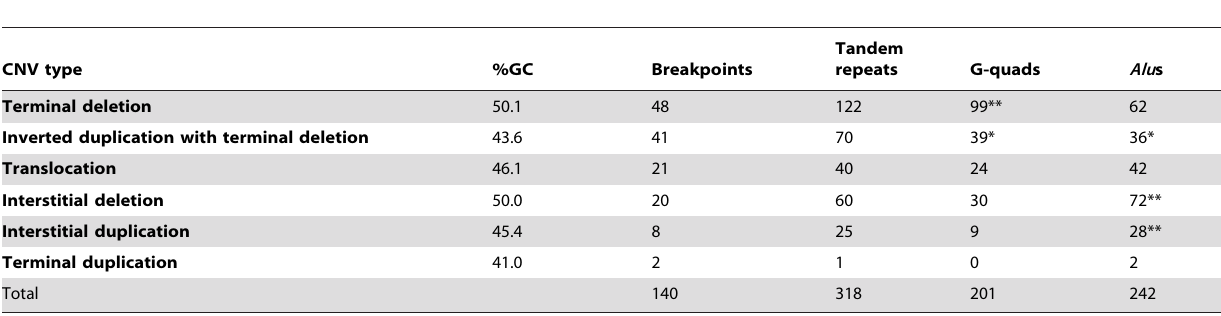
Table 1. Repeats enriched and depleted in CNV breakpoints. The GC content and number of breakpoints are listed for the six CNV